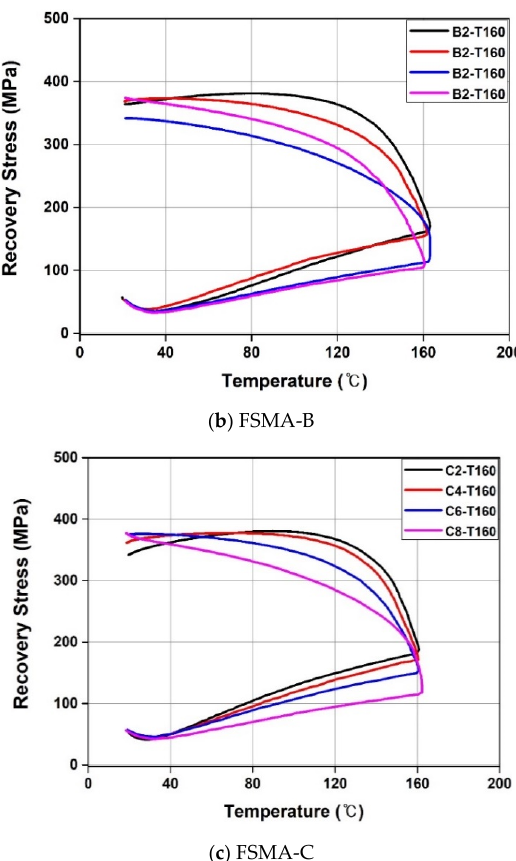
Figure 7. Comparison of temperature ‐ recovery stress curves by pre ‐ strain under rigid restraint. In contrast to the FSMA ‐ A specimen, the recovery stress at the maximum temperature ( 𝜎 (cid:3040),(cid:3021) ) steadily decreased 10 MPa for every 0.02 of pre ‐ strain increase. However, the maximum recovery stress ( 𝜎 (cid:3040) ) and final recovery stress ( 𝜎 (cid:3033) ) were not affected by the increase of pre ‐ straining in the FSMA ‐ B specimen. This is because any pre ‐ strain over 0.02 does not affect to the recovery stress in Fe ‐ SMA [20]. With the same pre ‐ strain level, the final recovery stress ( 𝜎 (cid:3033) ) in the FSMA ‐ B specimen was approximately 19% smaller than one in the FSMA ‐ A specimen. This is due to the fact that the recovery stress depends on the yield strength rather than the recovery strain [2]. The maximum recovery stress ( 𝜎 (cid:3040) ) and final recovery stress ( 𝜎 (cid:3033) ) with 0.02 of pre ‐ strain in the FSMA ‐ B specimen are 381 MPa and 364 MPa. The short ‐ term relaxation of the FSMA ‐ B specimen is evaluated at 17.21 MPa. Afterward, the short ‐ term relaxation gradually decreased as the pre ‐ strain increased. The short ‐ term relaxations in pre ‐ strains of 0.06 and 0.08 are 0.4 MPa and 0.13 MPa.